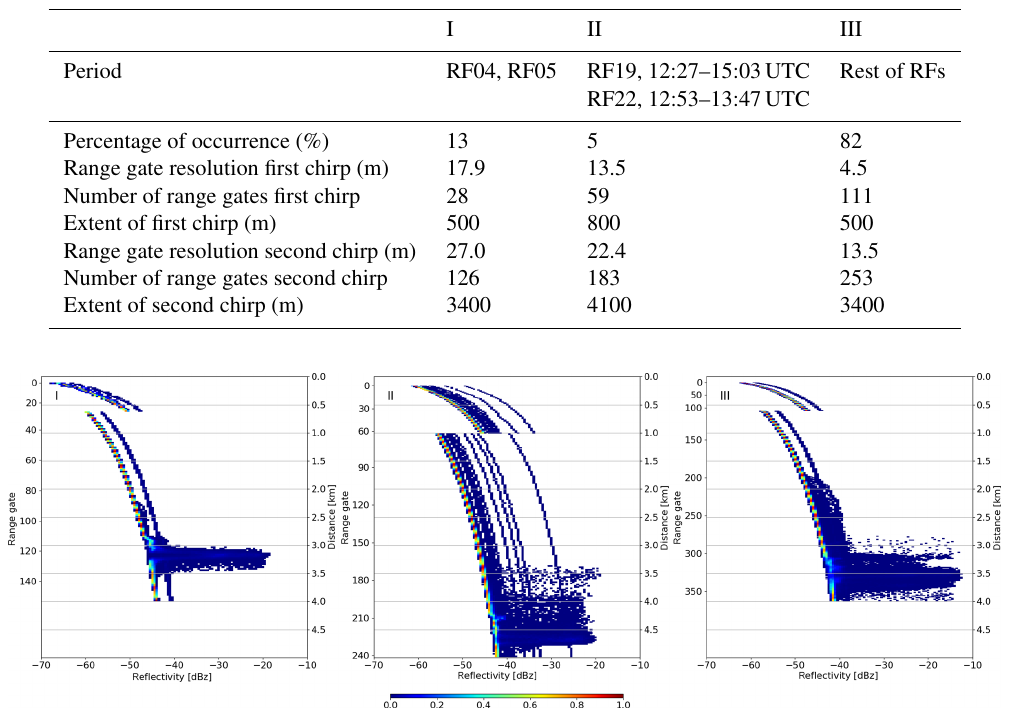
Table 1. Chirp settings and corresponding range resolution for the different research flights (RFs). MiRAC has been operated on 19 RFs.